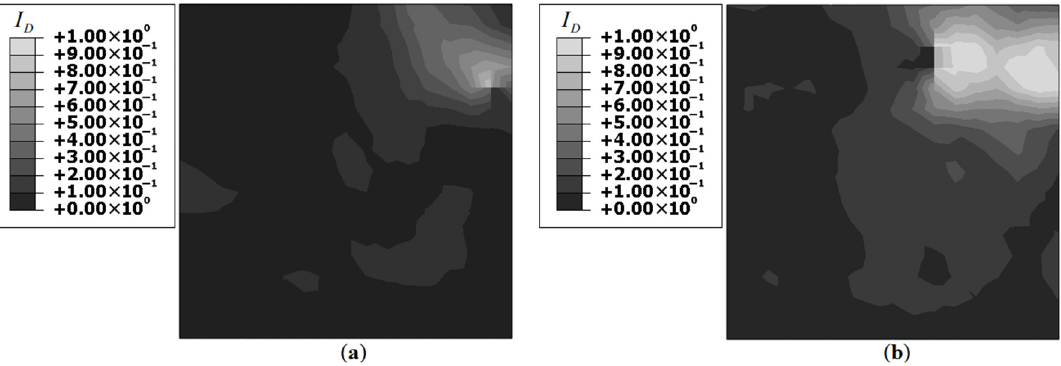
Figure 16. iFEM reconstructed 𝐼 (cid:3005) distribution for Damage Case-2 using: ( a ) Unitcell-1, and ( b ) Unitcell-2.